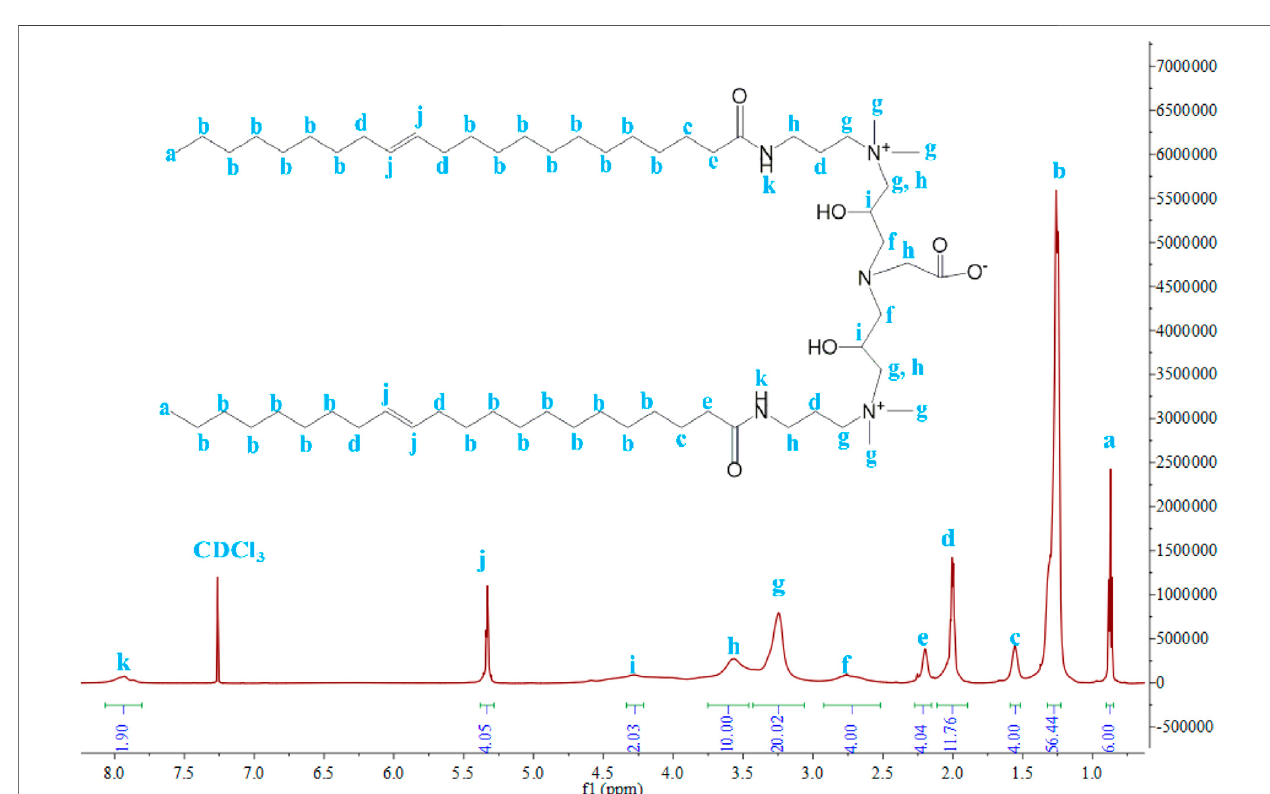
FIGURE 2 | 1 H NMR of